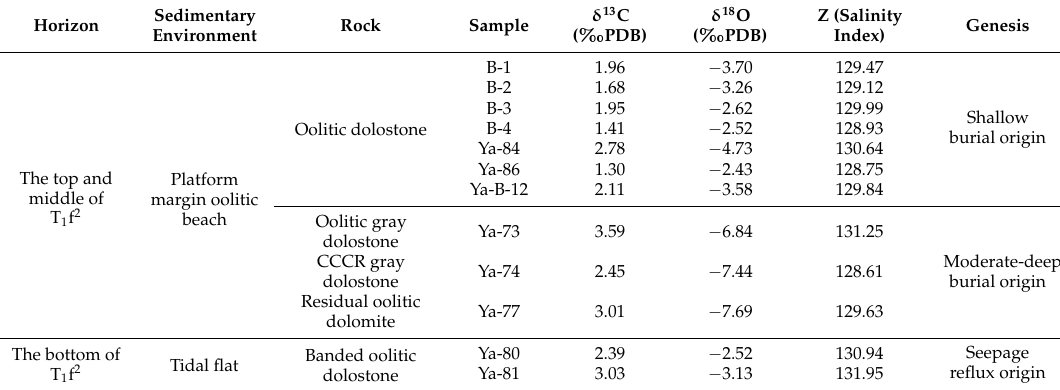
Table 3. Carbon and oxygen isotope data for dolomites from the Yudongzi